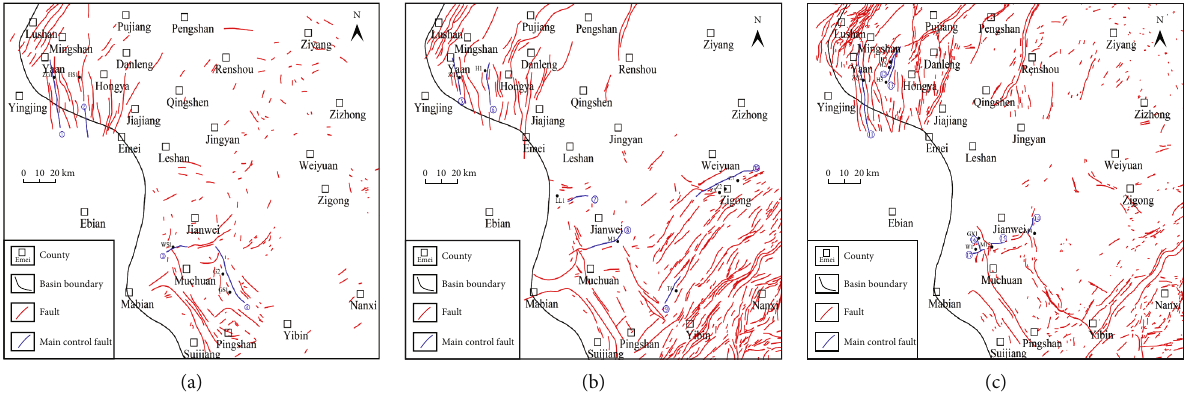
Figure 5: Planar distribution of faults in the key horizons in southwestern Sichuan Basin. (a) Cambrian bottom. (b) Upper Permian bottom. (c) Triassic